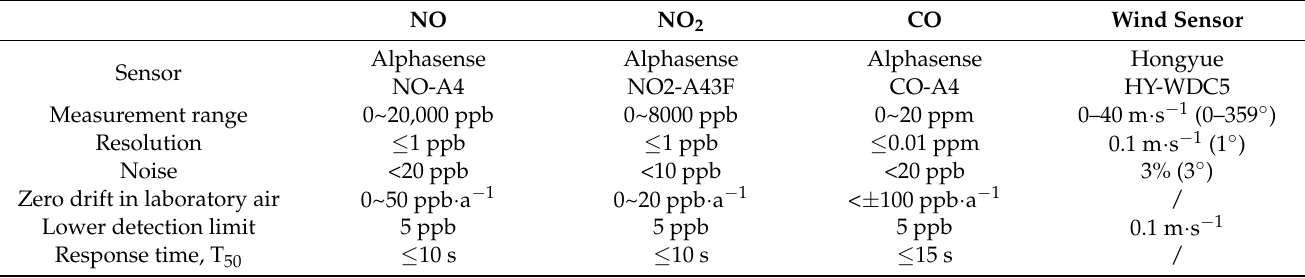
Table 1. Technical details for the monitoring